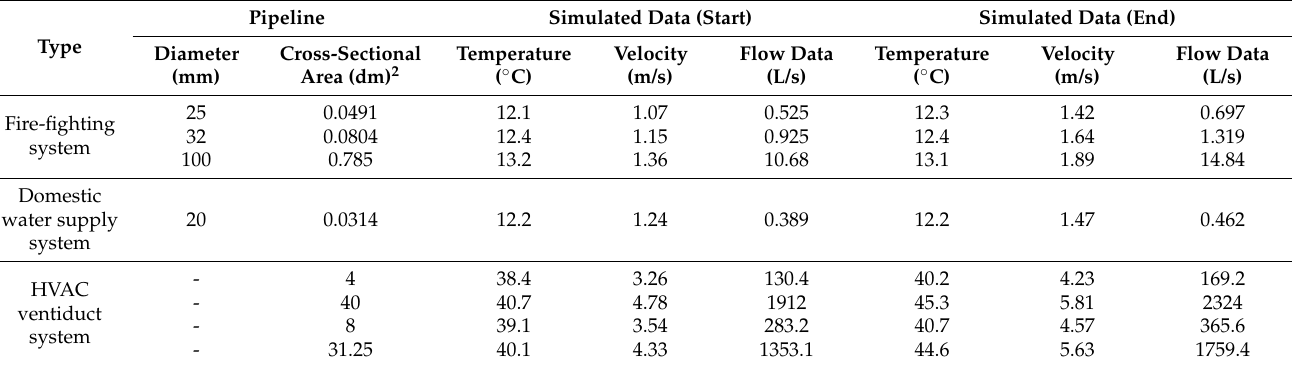
Table 4. Simulated data used in the experiments.